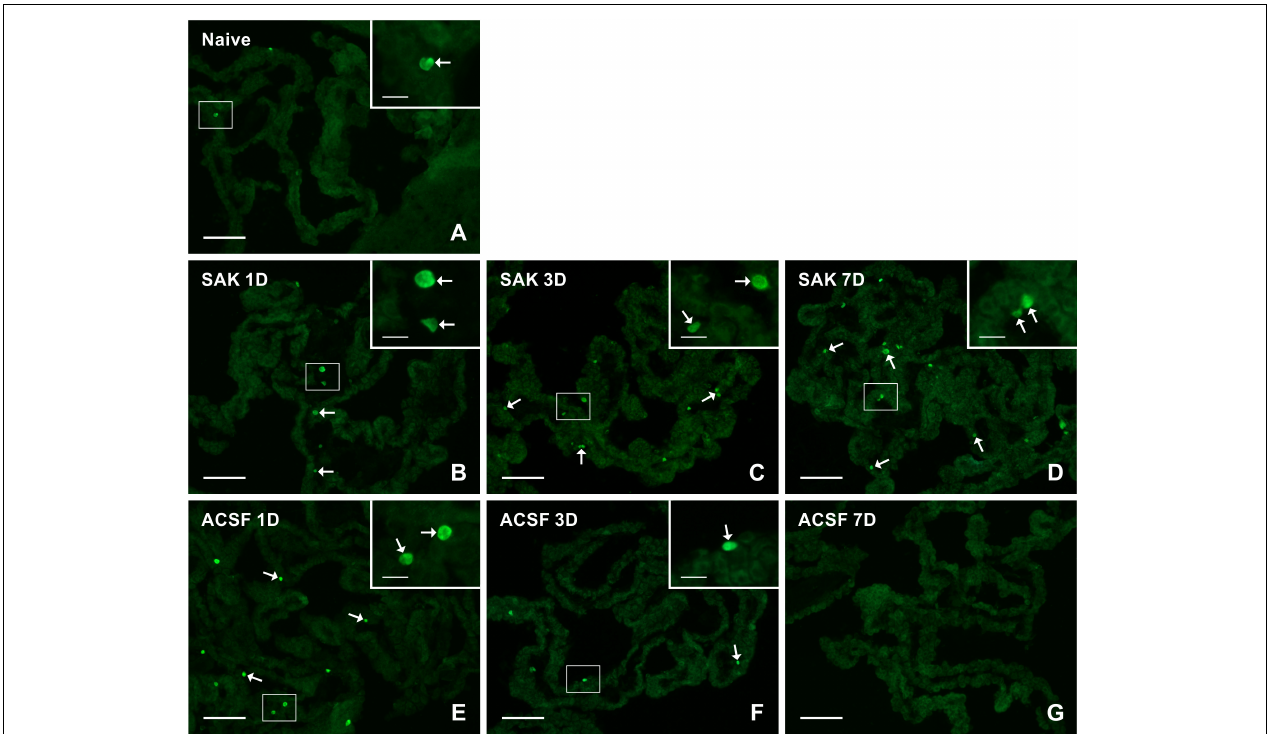
FIGURE 7 | Representative pictures of cryostat sections through the CP showing immunostaining with Ki67 antibody from naïve (A) , SAH (B–D) , and ACSF (E–G) rats at 1, 3, and 7 days (1D, 3D, and 7D) after operation. SAH induced a progressive increase in the number of proliferating cells 1, 3, and 7 days after injection of blood. ACSF application led to an increase in the number of KI67+ cells 1 and 3 days after operation. Arrows indicate Ki67+ cells in the epiplexus position of the CP. Insets show a higher magnification of regions marked by the boxes. Scale bars = 80 µ m (main image); 10 µ m